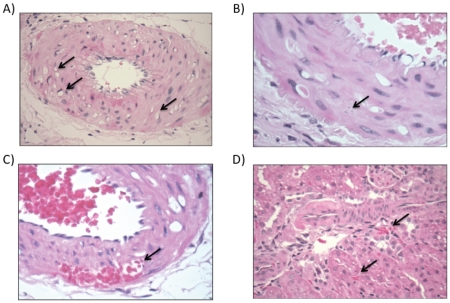
Temporal progression of microvascular injury in kidneys from cyp1a1-Ren2 transgenic rats.(A) After 1 day of transgene activation myocycte vacuolation was observed in the media of the larger arteries (indicated by arrow). (B) After 3 days apoptotic nuclear fragments were observed (arrow) and (C) there were areas of hemorrhage into necrotic foci. (D) After 7 days, vasculopathy was more extensive still and there were foci of tubulointerstitial injury.